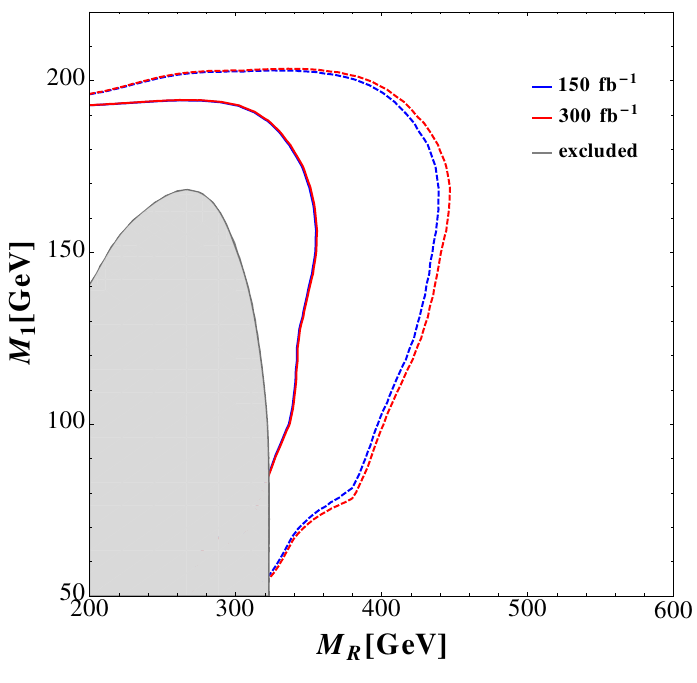
√ Figure 4 . NP discovery region for the LHC at s = 13 TeV. The blue (red) curve represents the results for 150 (300) fb − 1 . Points that lie to the left of the blue and red curves have an expected discovery significance of ≥ 5 σ . The solid curves consider backgrounds from fake electrons and charge mismeasurements, while the dashed curves consider only backgrounds from fake electrons and no charge mismeasurements. The gray region is excluded by the searches described in section 4. Here λ = 0 . 042